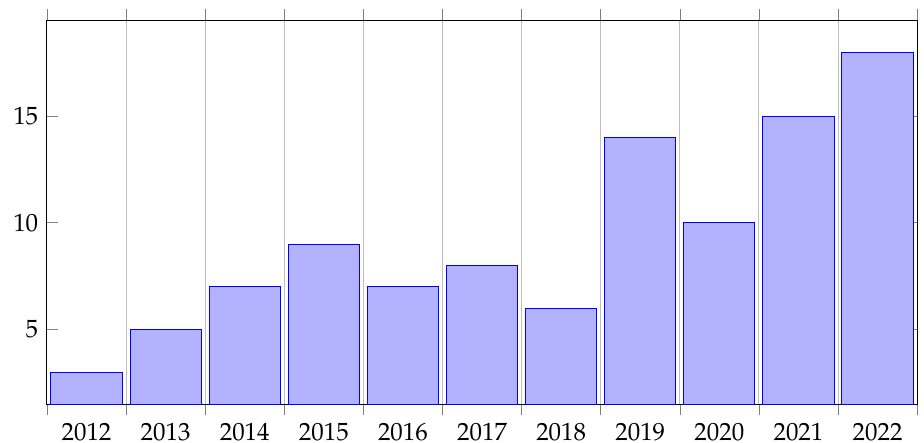
Figure 1. Yearly count of articled published on the Web of Science.